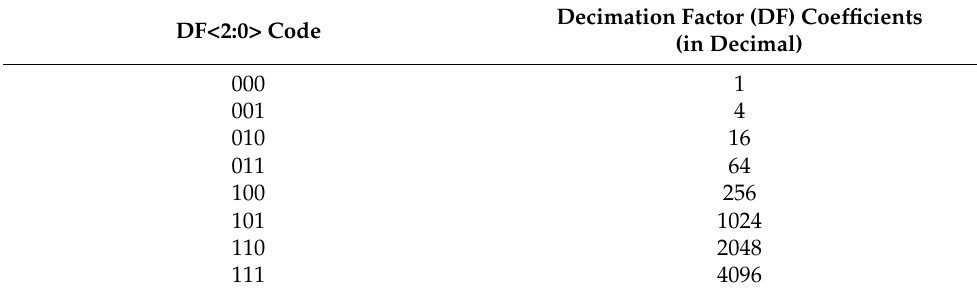
Table 1. Decimation factor (DF) coefficients according to DF<2:0> codes.